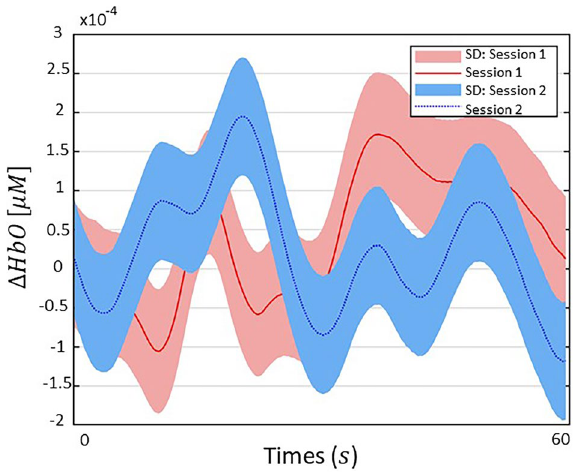
Figure 4. Hemodynamic responses for the averaged change concentration of ∆HbO between Session 1 and Session 2. The ∆HbO represents the average interval from the start to the end of the task (0–60 s) acquired from 30 participants. The solid red line and dotted blue line are ∆HbOs of Session 1 and Session 2, respectively. The corresponding shaded colors are the standard deviations (s.d.) from the mean signals. The hemodynamic signals between the two sessions are markedly different ( t = 3.297 ; ∗∗∗ p < 0.001 ), indicating the role of biomarkers for those who show impulse buying patterns.